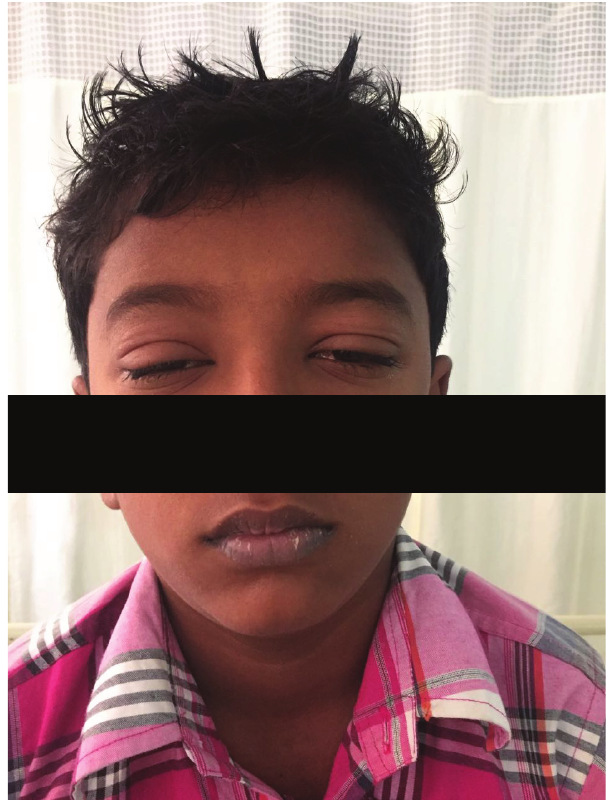
Figure 1. Clinical photograph showing swollen eyelids and crusted lesions on